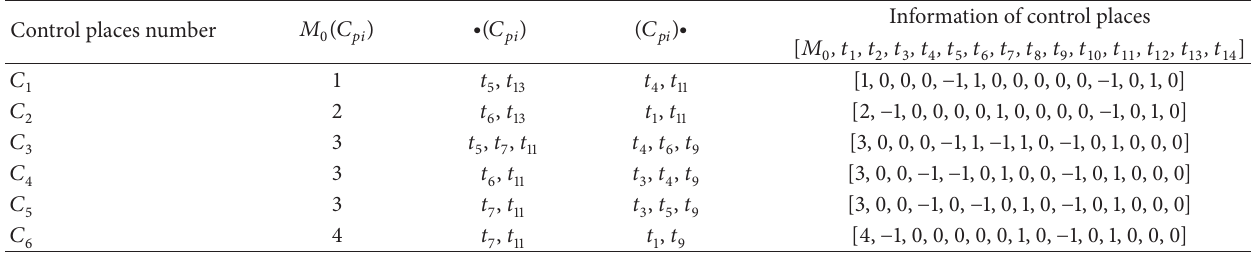
Table 10: The additional control places in this example.